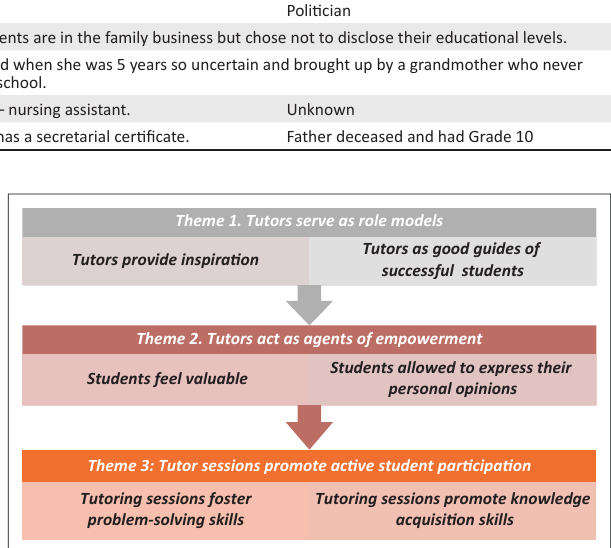
FIGURE 2: Themes and subthemes derived from